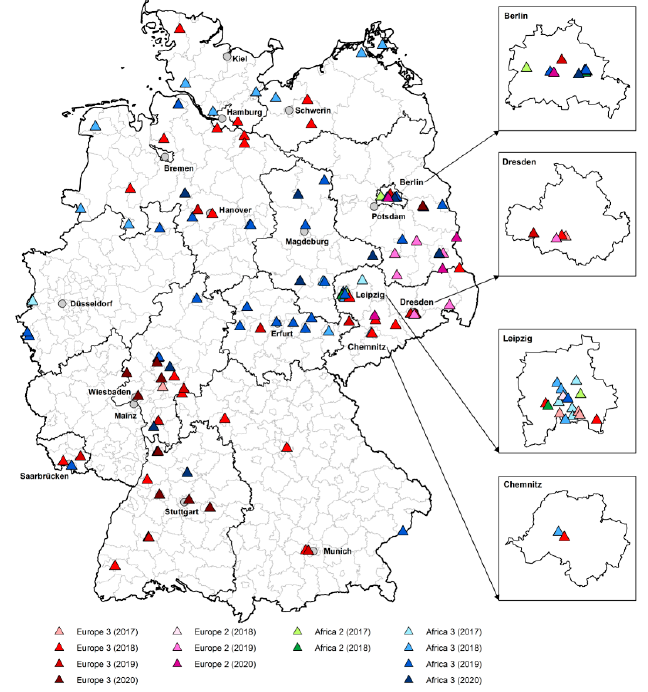
Figure 2. Circulation of the different USUV lineages in Germany from 2017 to 2020. The map includes 66 new partial USUV sequences from 2019 and 2020 (blood samples from birds in our first panel = live bird monitoring, and organ samples from the second panel = dead bird monitoring) and 60 sequences from a previous study from 2017 to 2018 published by Michel et al. [22], as well as six full-genome USUV sequences from birds of the co-infection study by Santos et al. [57]. The different USUV lineages are depicted as colored triangles: red = Europe 3, blue = Africa 3, green = Africa 2, and purple = Europe 2. Different shades of each of these colors indicate the years of detection of each USUV lineage.